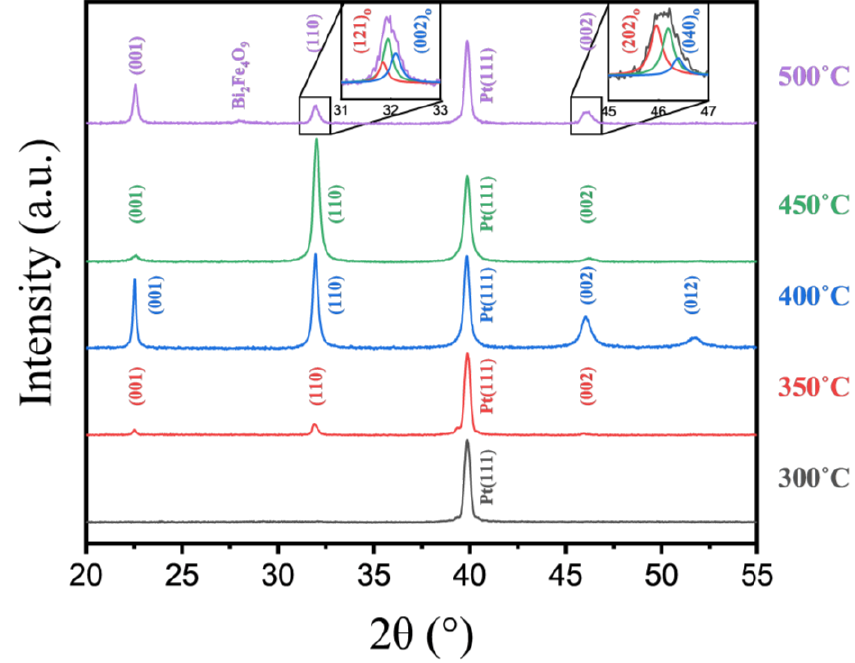
Figure 6. XRD patterns of Bi 0.9 Gd 0.1 FeO 3 ( T g = 300, 350, 400, 450, and 500 °C) films. For Bi 0.9 Gd 0.1 FeO 3 films with T g = 350 – 500 °C, electrical polarization electric ( P - E ) field